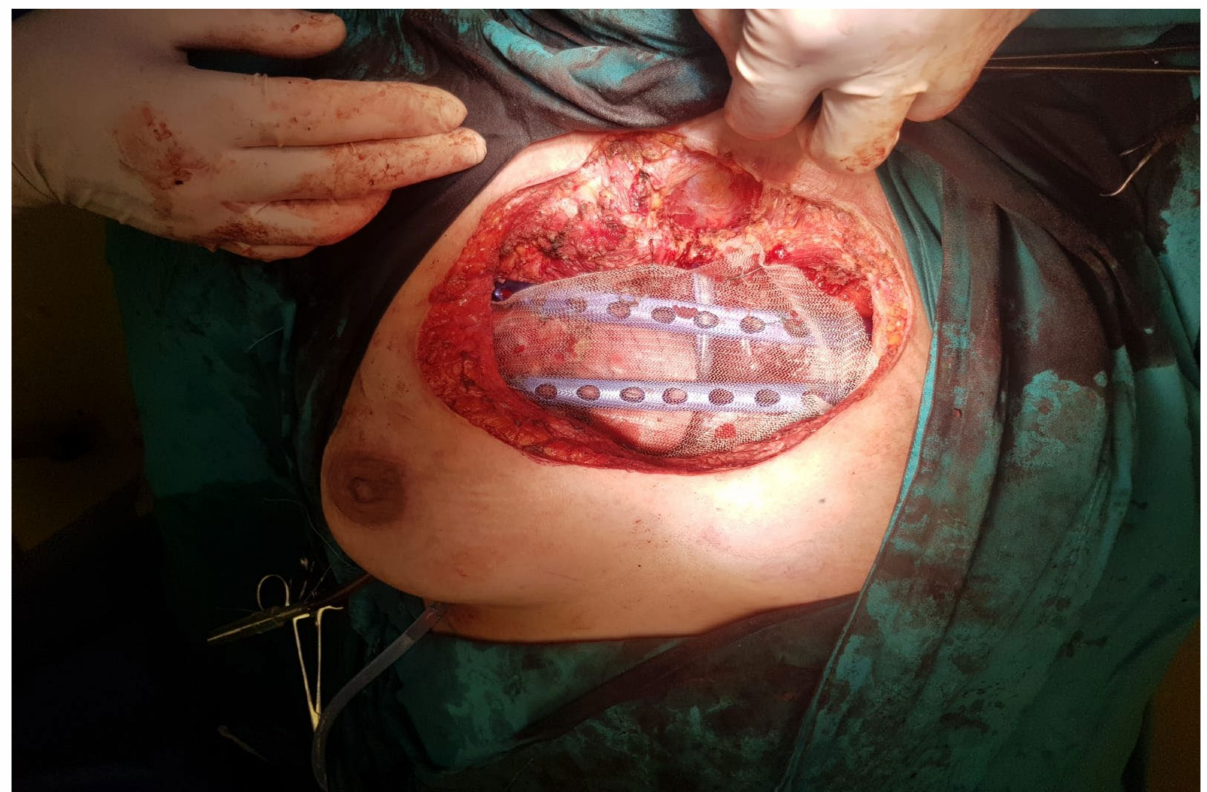
Figure 11. The isolated left brachiocephalic trunk, during surgery.